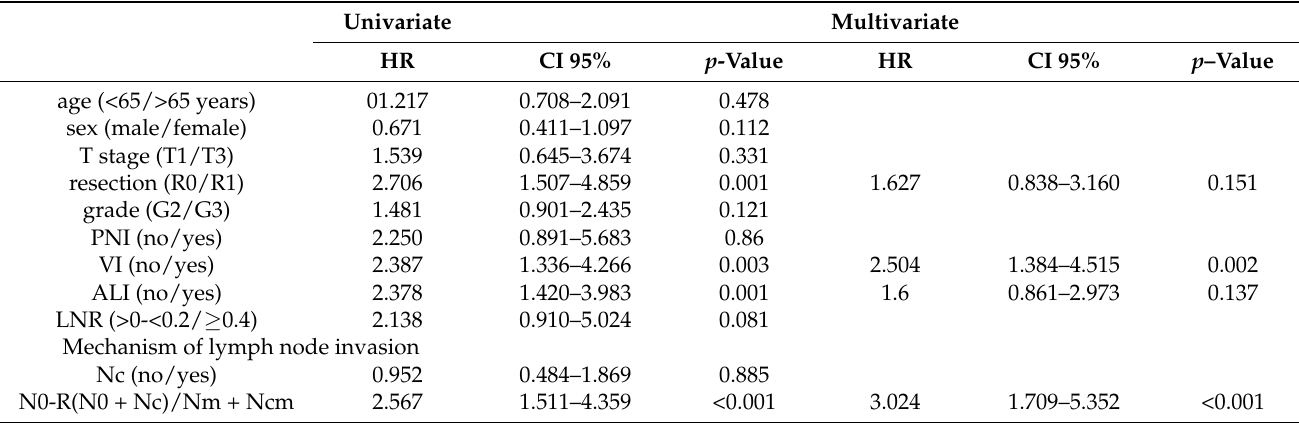
Table 2. Univariate and multivariate analysis of prognostic factors.